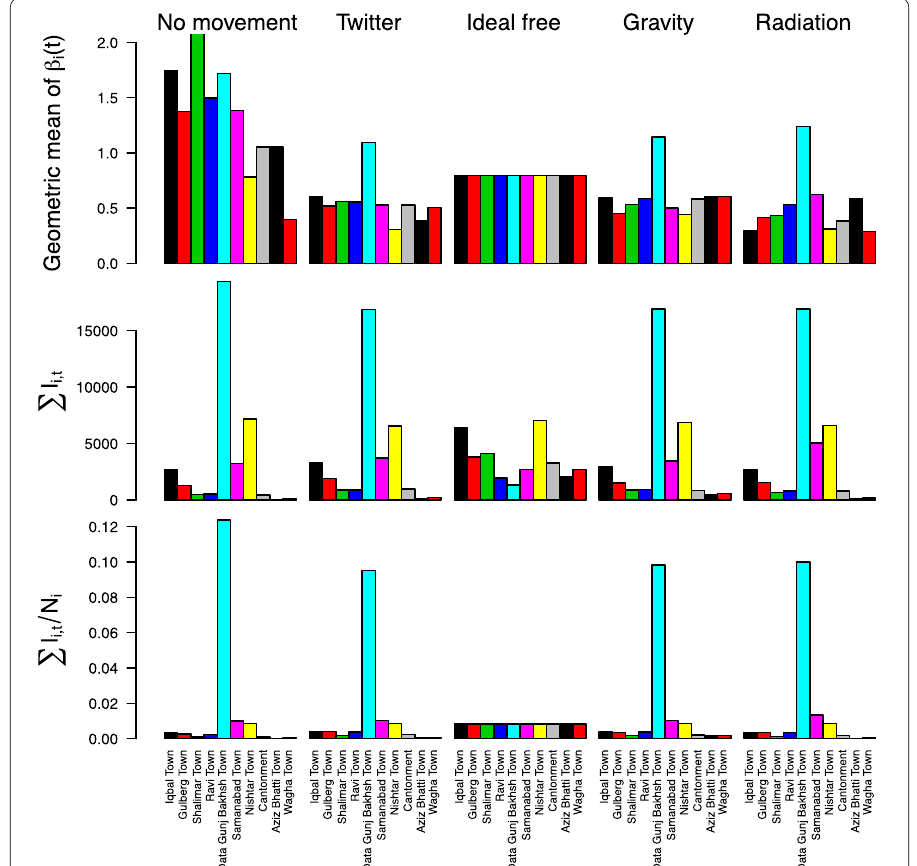
Figure 9 Measures of transmission and incidence across towns (colors) under different mobility assumptions (columns) aggregated over the entire 2011–2014 time period. The upper left y-axis was cut off to permit viewing of the majority of values; the geometric mean of β i ( t ) for Shalimar town is